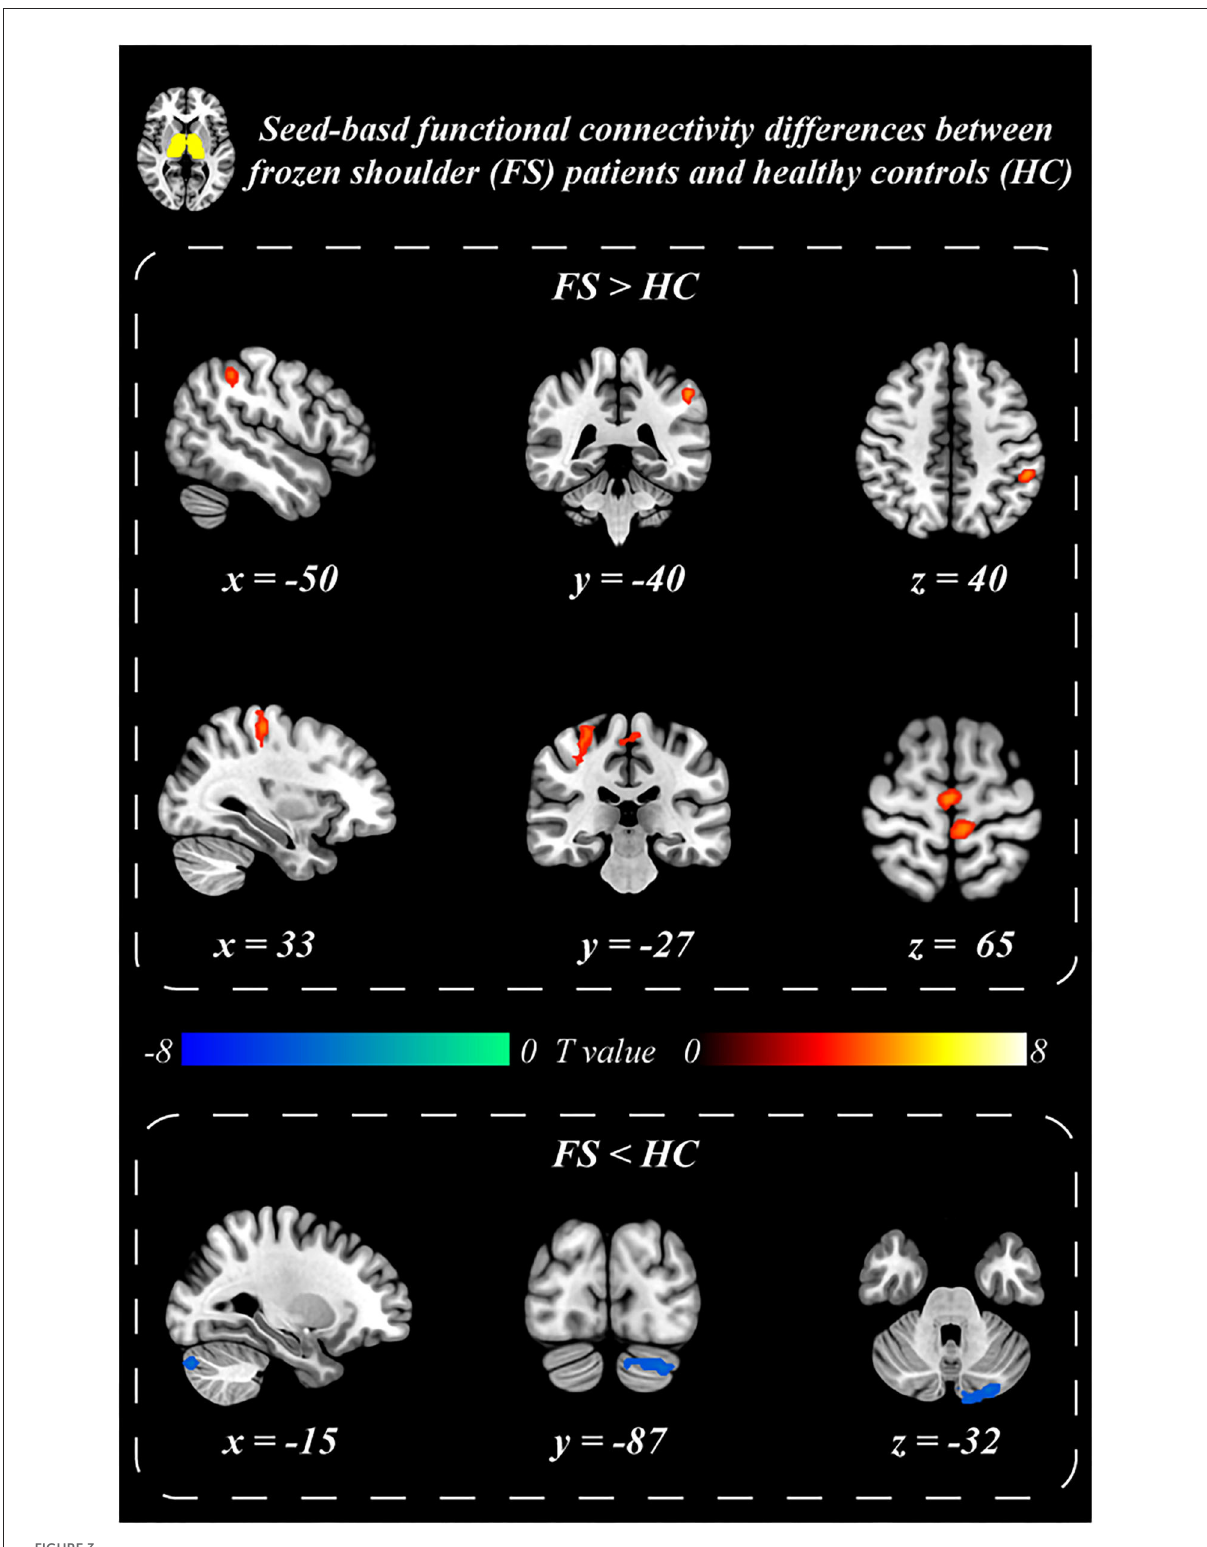
FIGURE3 Seed-based functional connectivity differences between BC patients and healthy controls. Thalamus exhibited stronger resting-state functional connectivity with postcentral gyrus (SI) and inferior parietal lobule (IPL), and weaker functional connectivity with the Cerebellum in BC patients than that in the healthy